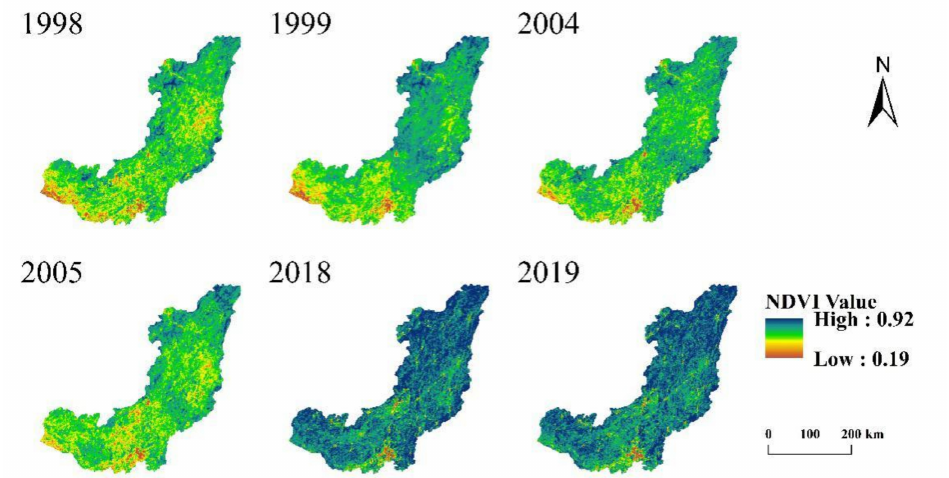
Figure 10. Spatial distribution of NDVI in Wujiang River Basin in 1998, 1999, 2004, 2005, 2018, 2019.